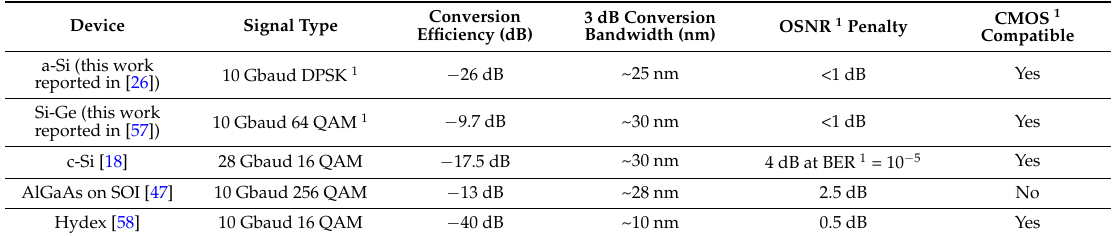
Table 5. Integrated wavelength converter technology comparison.